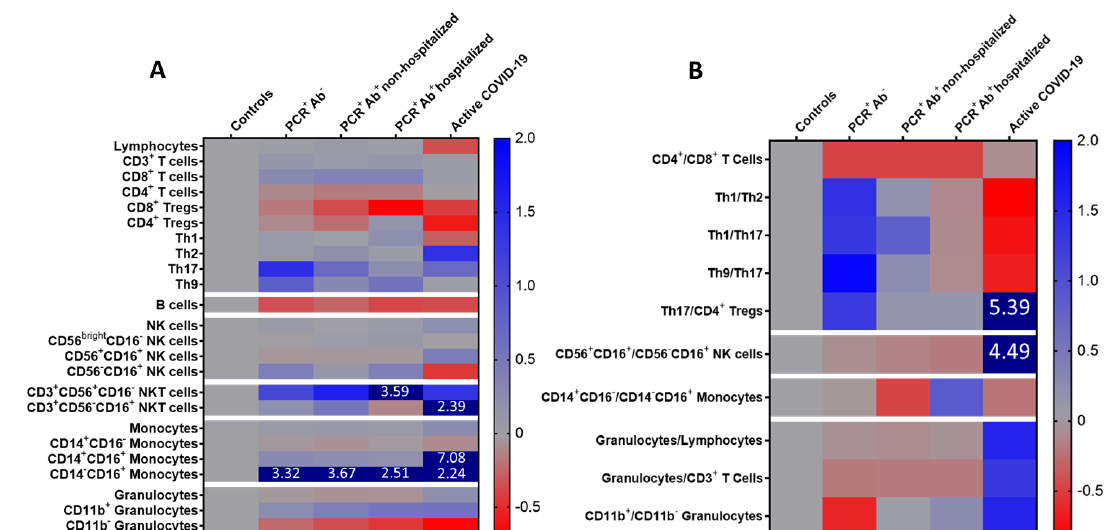
Figure 3. Heatmap of the mean percentages for ( A ) white blood cell populations and ( B ) subpopulation ratios in recovered convalescent plasma (CP) donors and active COVID-19 patients expressed as fold-increase compared to the control group defined as 0. Colors were mapped linearly as in the colored key shown (low in red; high in blue). Numerical values indicate differences exceeding the color scale bar limits.